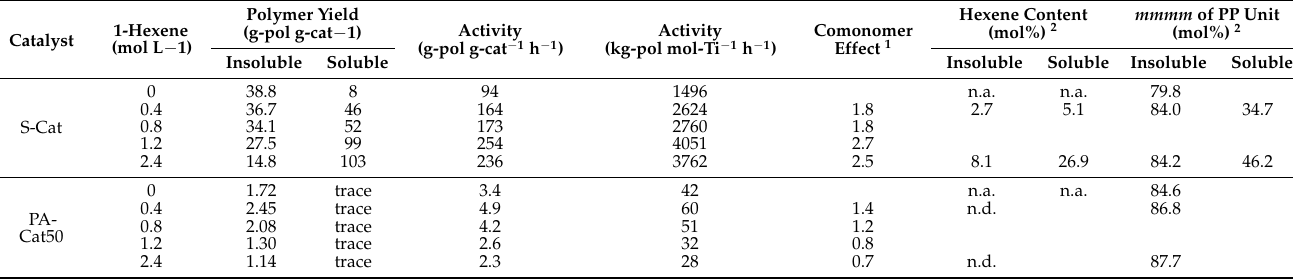
Table 4. 1-Hexene copolymerization with